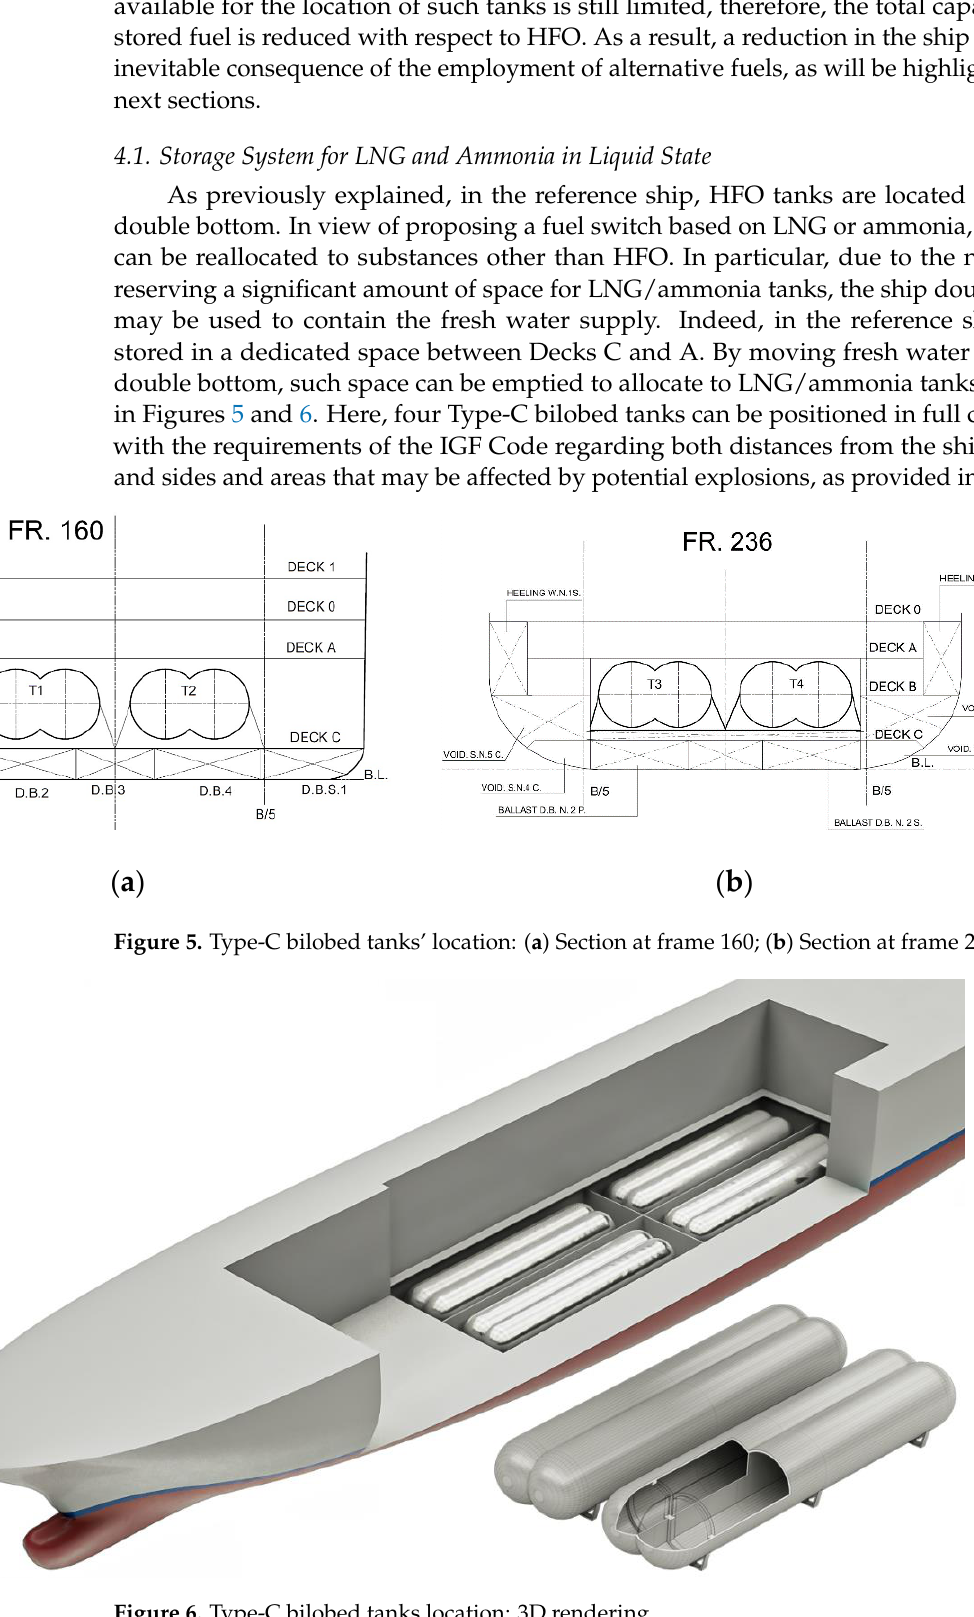
Figure 6. Type-C bilobed tanks location: 3D rendering. Table 5. Geometric properties and positions of the Type-C bilobed tanks selected. Tank